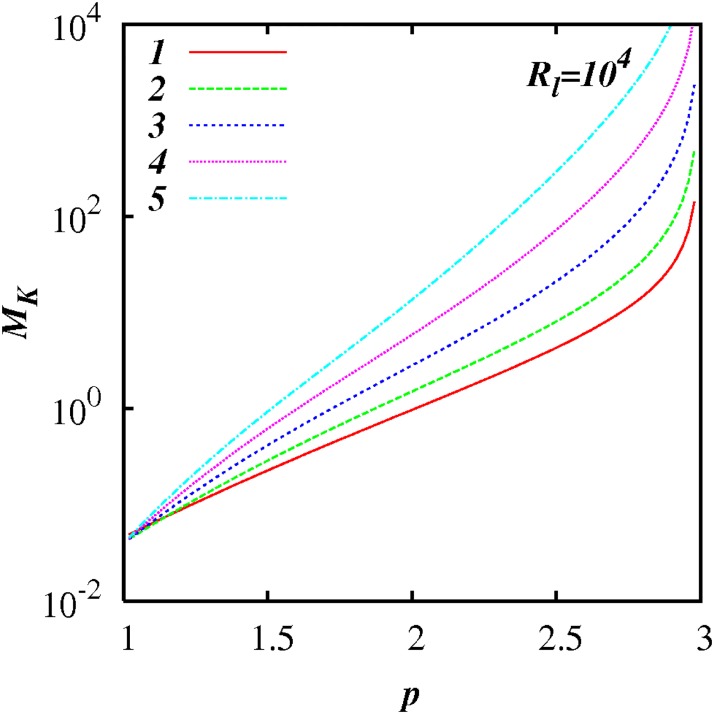
Similar to Fig 3, except for Rl = 104.